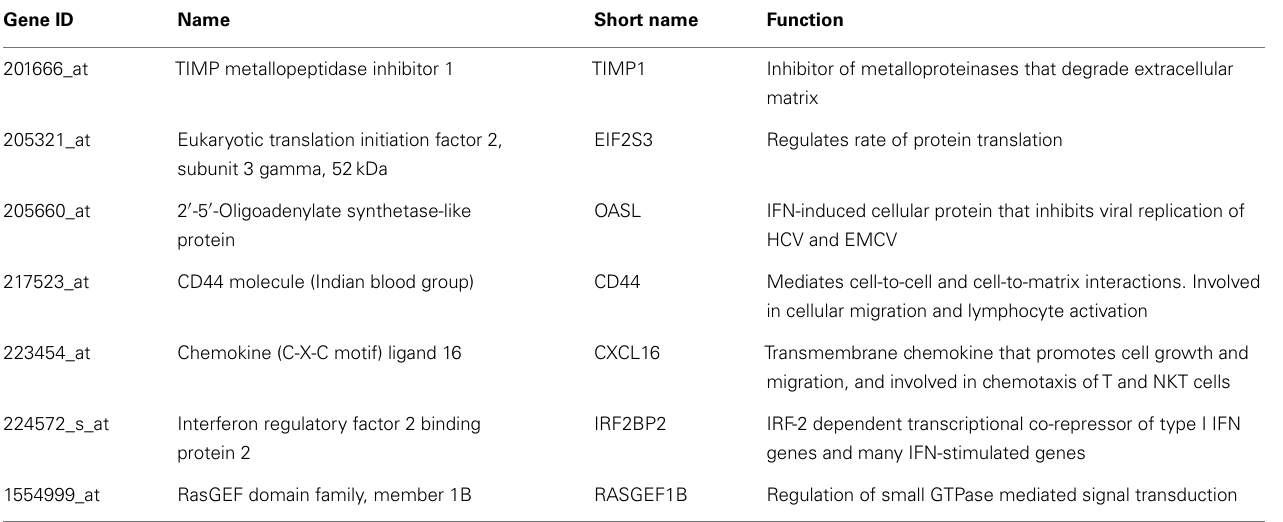
TableA3 | Genes up regulated in all HCV vasculitis subjects compared to others